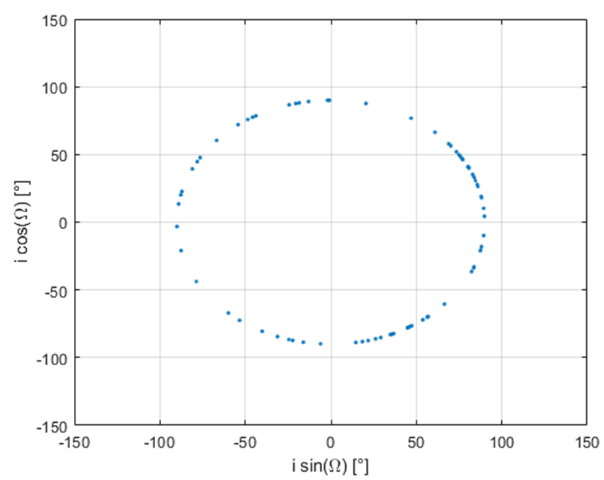
Figure 13. Distribution of reference fragments in plane i sin ( Ω )-i cos ( Ω ) for second test case.